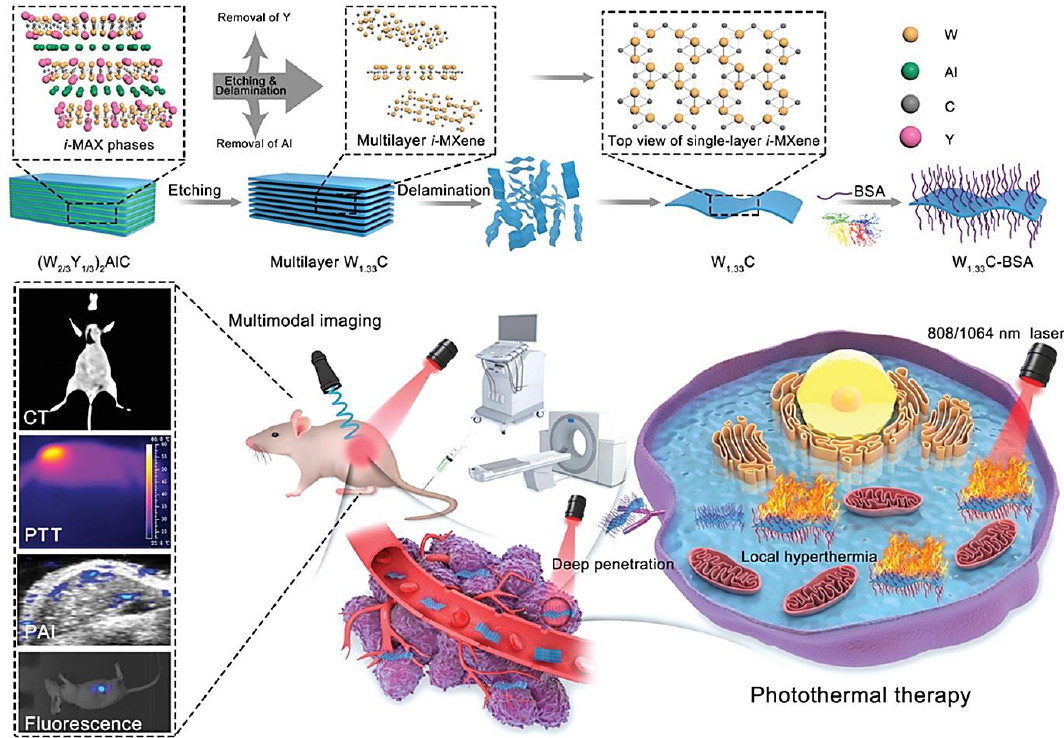
Figure 3. The preparative process of bovine serum albumin (BSA)-modified W 1 . 33 C i -MXene with high photothermal conversion efficacy for theranostic applications (multimodal imaging and pho- tothermal therapy). CT: computed tomography; PTT: photothermal therapy; and PAI: photoacous- tic imaging. Adapted from Reference [77] with permission (CC BY). Copyright: 2021, Wiley-VCH GmbH.